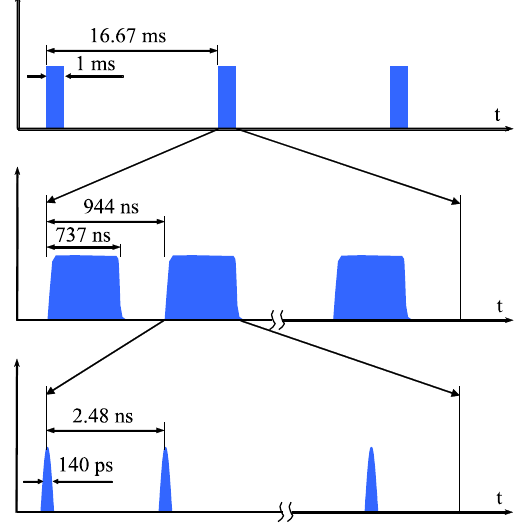
FIG. 1. TypicaltimestructureoftheneutronproductionH − beam macropulses (top), minipulses (middle), and micropulses (bottom) in the high energy beam transport (HEBT) of the SNS accelerator.